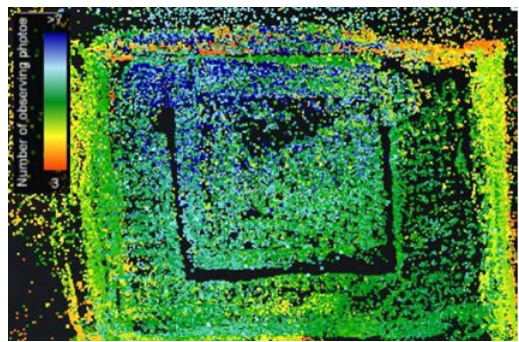
Figure 10 - Number of observing photos per tie point.